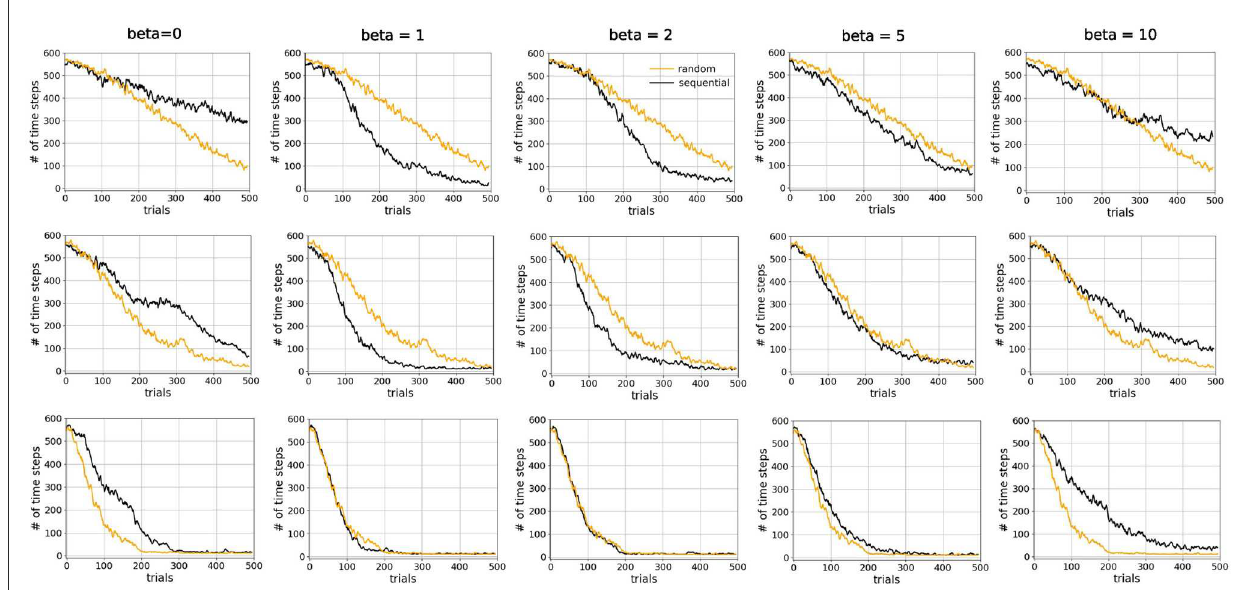
FIGURE11 Sequential replay outperforms random replay when number of replays is limited. Comparison of learning curves for random replay (orange) and sequential replay (black) in tunnel maze v4. The top, middle, and bottom rows show results for 10, 20, and 50 replays, respectively. Within each row the same curve for random replay is repeated in every column to facilitated easier comparisons. Each data point was averaged over 50